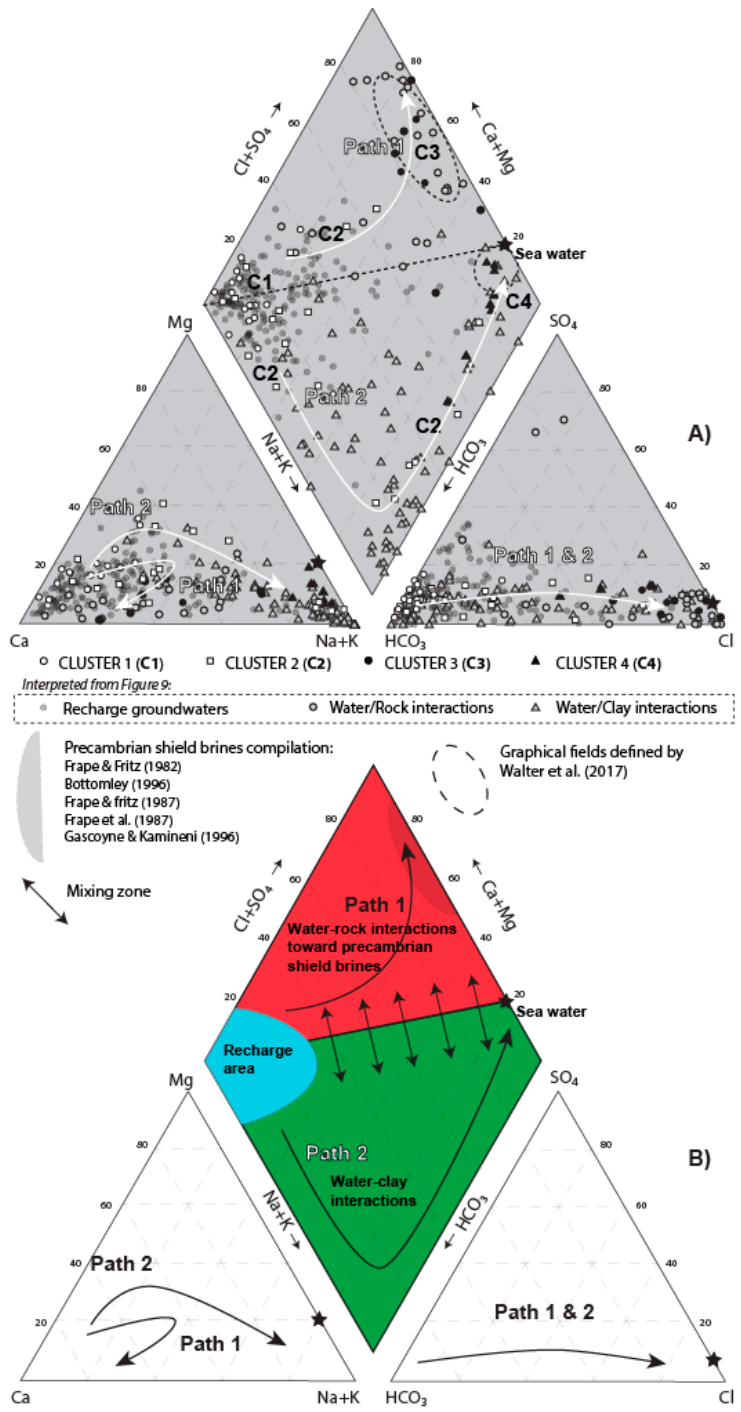
Figure 10. ( A ) Piper diagram showing the geochemical evolution of groundwater according to the first approximation of the hydrogeochemical context (recharge-type groundwater, water-rock-type interactions, and water-clay-type interactions) interpreted using a Ca 2+ vs. Na + binary plot (Figure 9). ( B ) New graphical fields and improved interpretations of the Piper diagram for groundwater evolving in Precambrian terrain invaded previously by seawater.